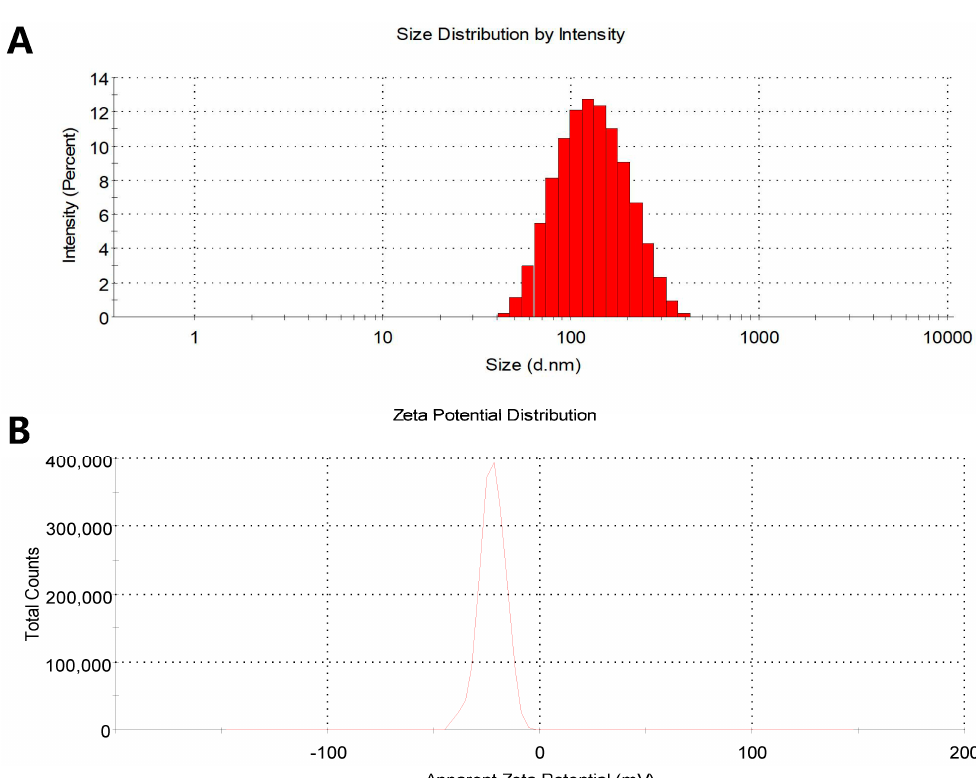
Figure 1. Characteristics of the liver-targeted baicalin liposomes (BAA1). ( A ) The particle size was measured by using the Malvern Zetasizer Nano ZS90 (Malvern Instruments Ltd., Malvern, UK). ( B ) Zeta potential was measured by using the Malvern Zetasizer Nano ZS90 (Malvern Instruments Ltd., Malvern, UK).